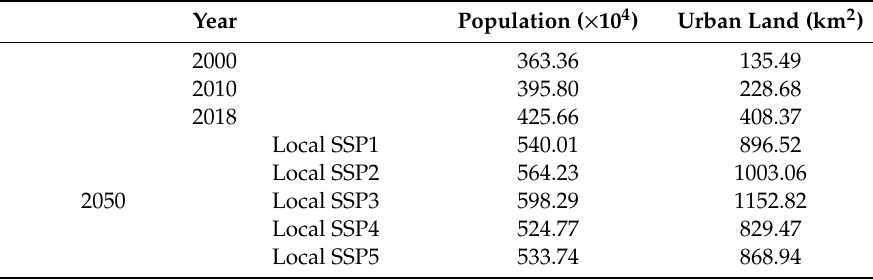
Table 1. Population and urban land from 2000 to